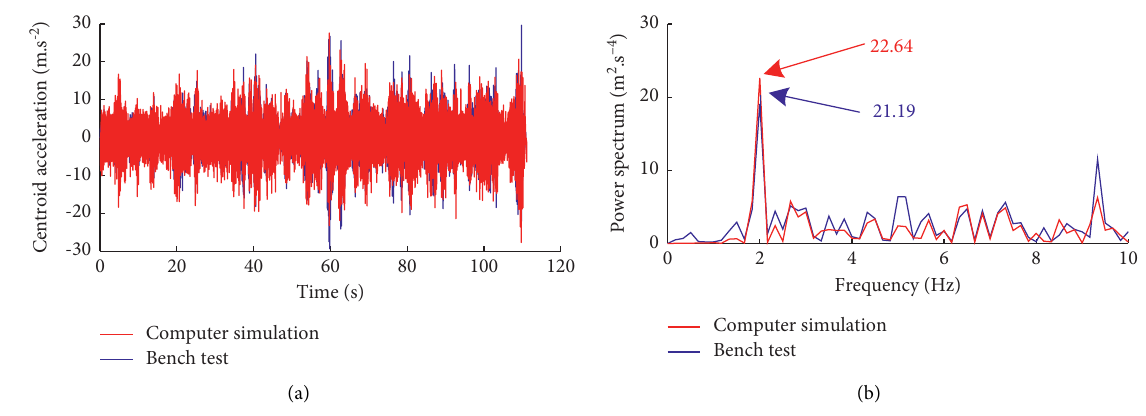
Figure 5: Acceleration curve and spectrum of vehicle mass center. Table 1: The comparison of the experiment and numerical calculation. RMS